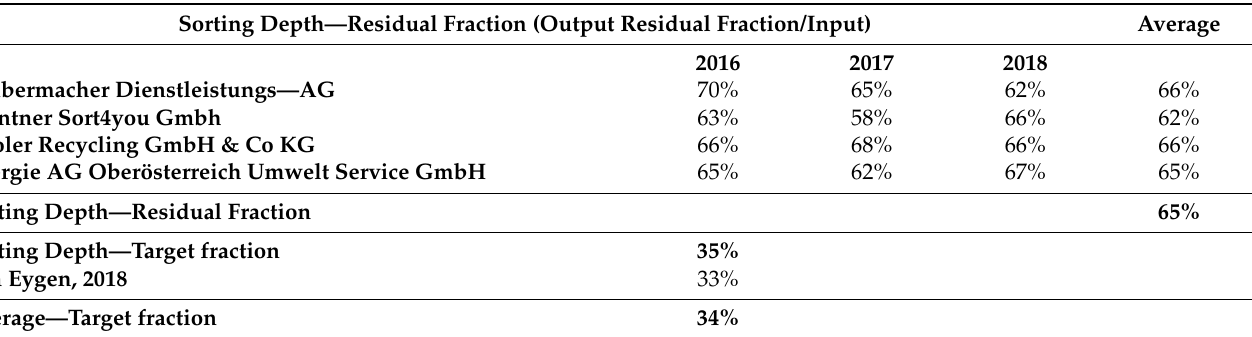
Table A3. Data collection and calculation of the sorting depth